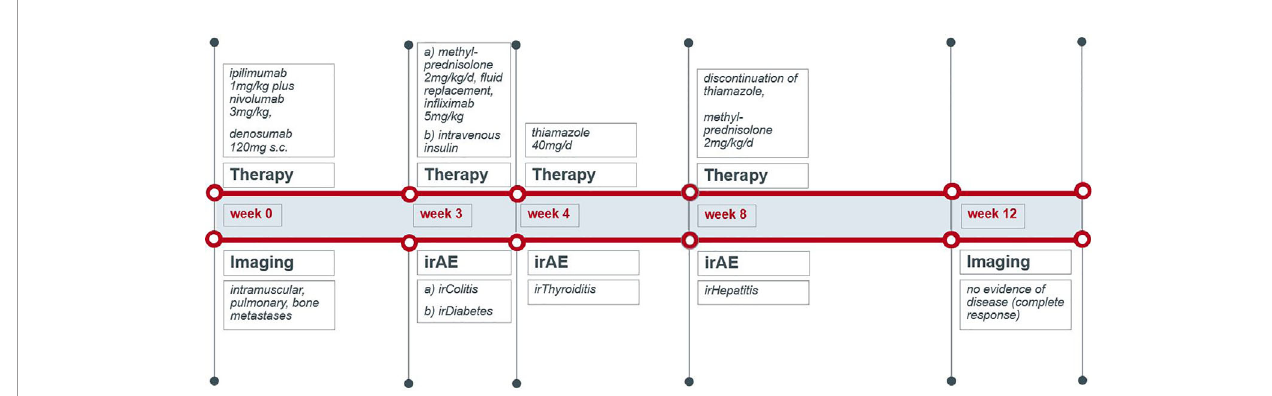
FIGURE 2 | Schematic timeline of immune checkpoint inhibition therapy and its immune-related adverse events. Figure 3A . Ultrasound showed a hypoechoic, heterogeneous, and hypervascular thyroid gland, and Tc99m thyroid scintigraphic scan revealed a slightly elevated uptake in both thyroid lobes